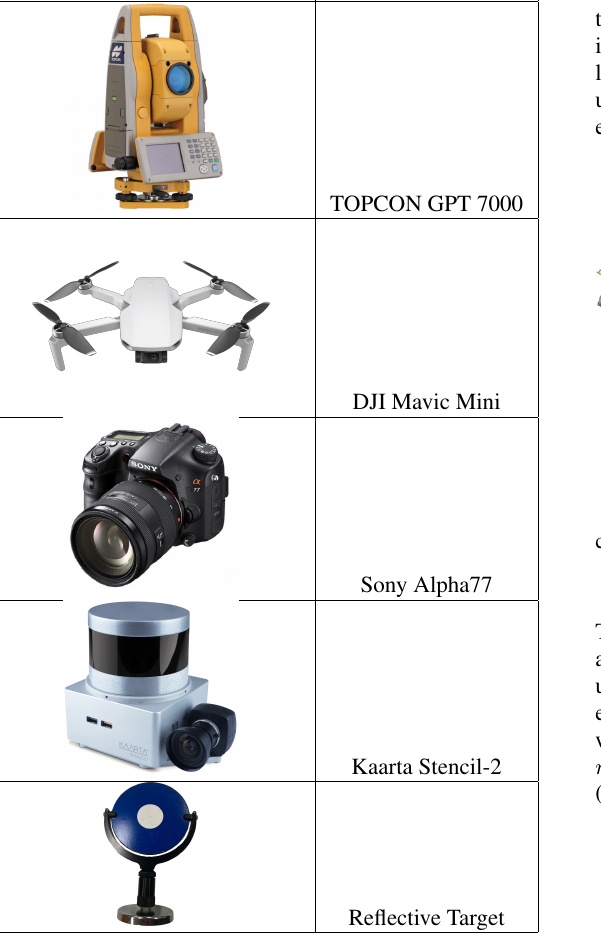
Table 1. Geomatic Equipment used for the surveys.